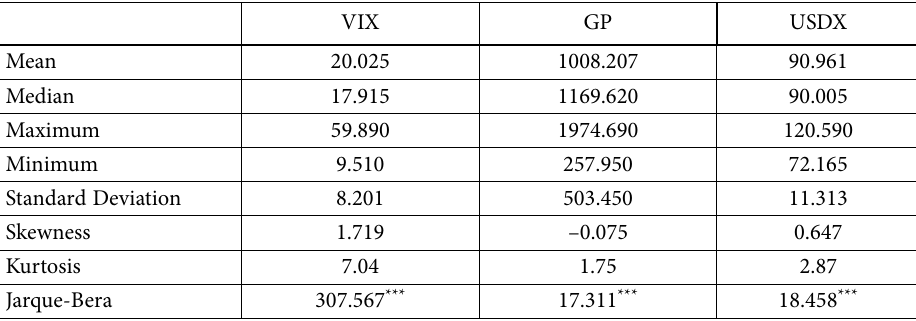
Table 1. Descriptive statistics for VIX and GP VIX GP